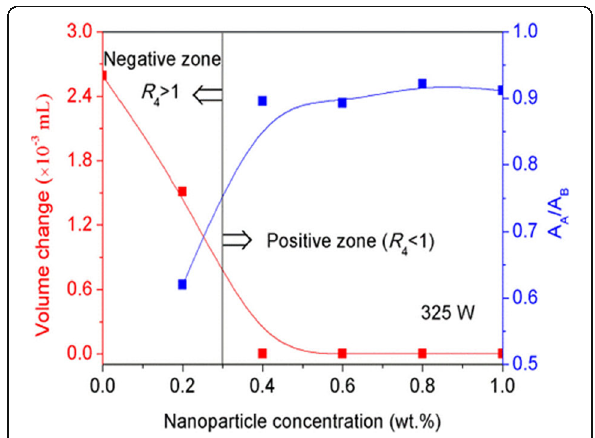
Fig. 7 Volume and absorbance variations of the Al 2 O 3 nanoparticle suspension caused by external ultrasound at different nanoparticle